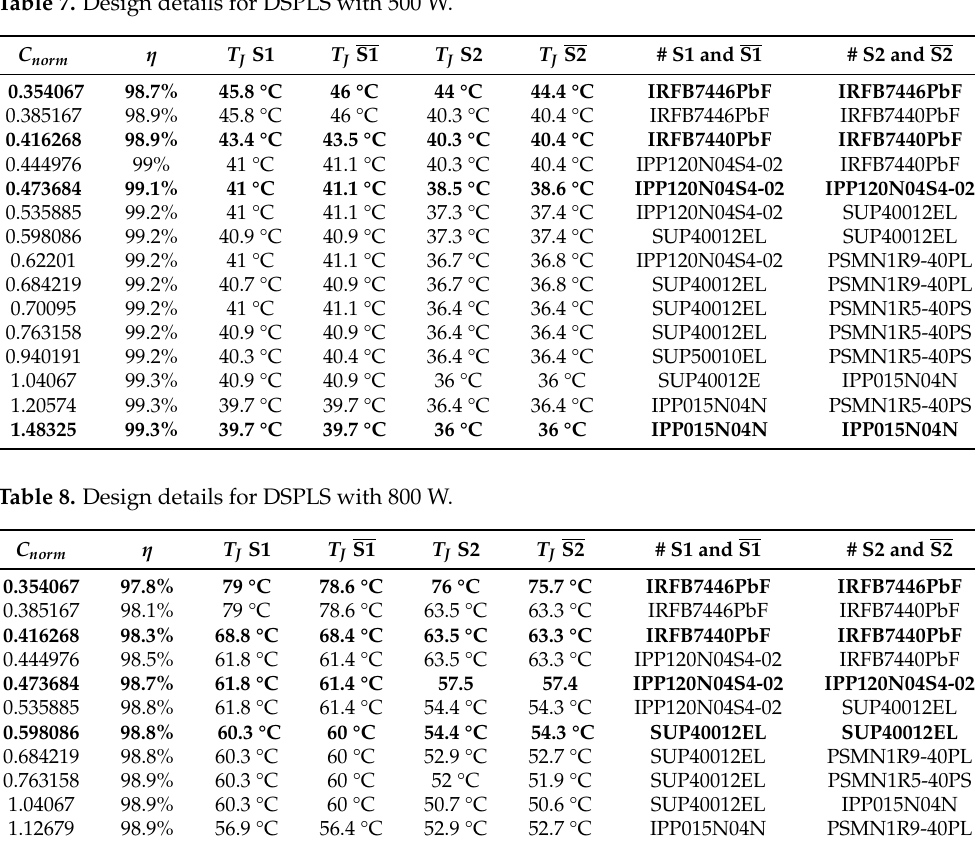
Figure 11. Pareto front for DSPLS. ( a ) 500 W. ( b ) 800 W. All part numbers of the optimal solutions are shown in Tables 7 and 8 for the powers of 500 W and 800 W, respectively, identifying the C norm , η and T J obtained with each transistor configuration. The highlighted rows represent the optimal solutions that use only 1 part number in all MOSFETs. These same part numbers are highlighted in Figure 11. Table 7. Design details for DSPLS with 500 W.